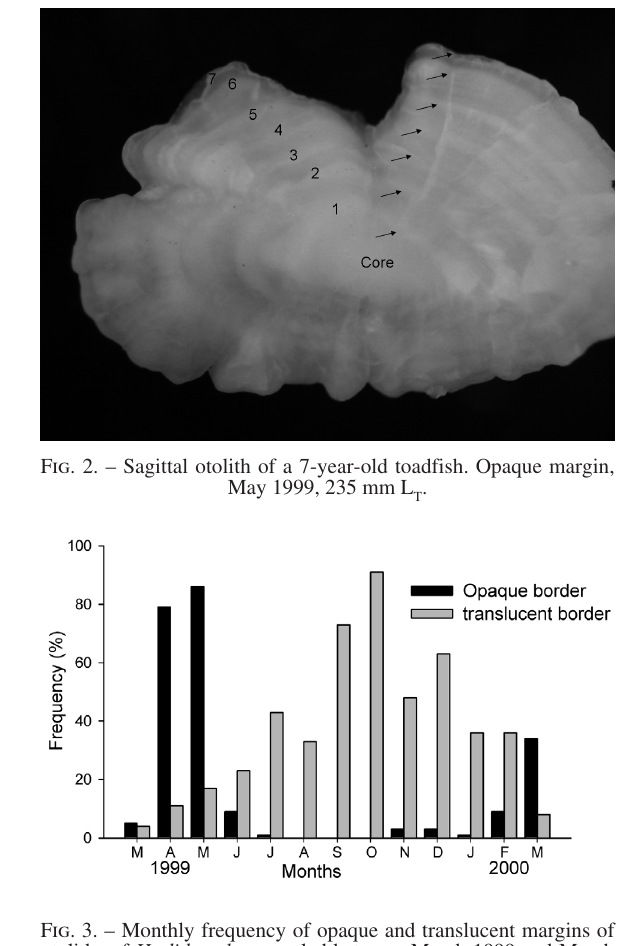
Fig . 1. – Length-frequency distributions (20-mm length classes) of male and female toadfish sampled for age determination in the Bay of Cádiz between March 1999 and March 2000.